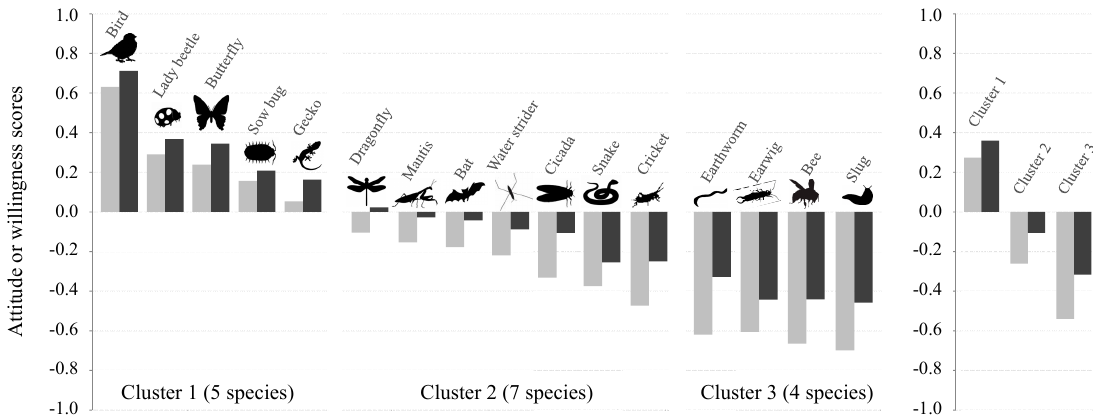
Figure 4. Attitude ( gray bars ) and willingness scores ( black bars ) for 16 animal species ( left panel ) and for three clusters (averaged values) ( right panel ). Species classification (Clusters 1, 2, and 3) were based on Ward’s dendrogram of a hierarchical cluster analysis (see also Figure S2).